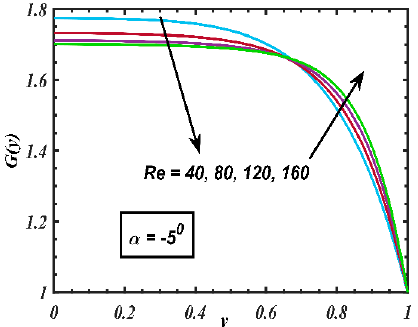
Figure 7. Variation of G(y) in converging channel for Re = 40, 80, 120, 160 and H = 0, Pr = 5, α = − 5 0 , Ec = 0 .